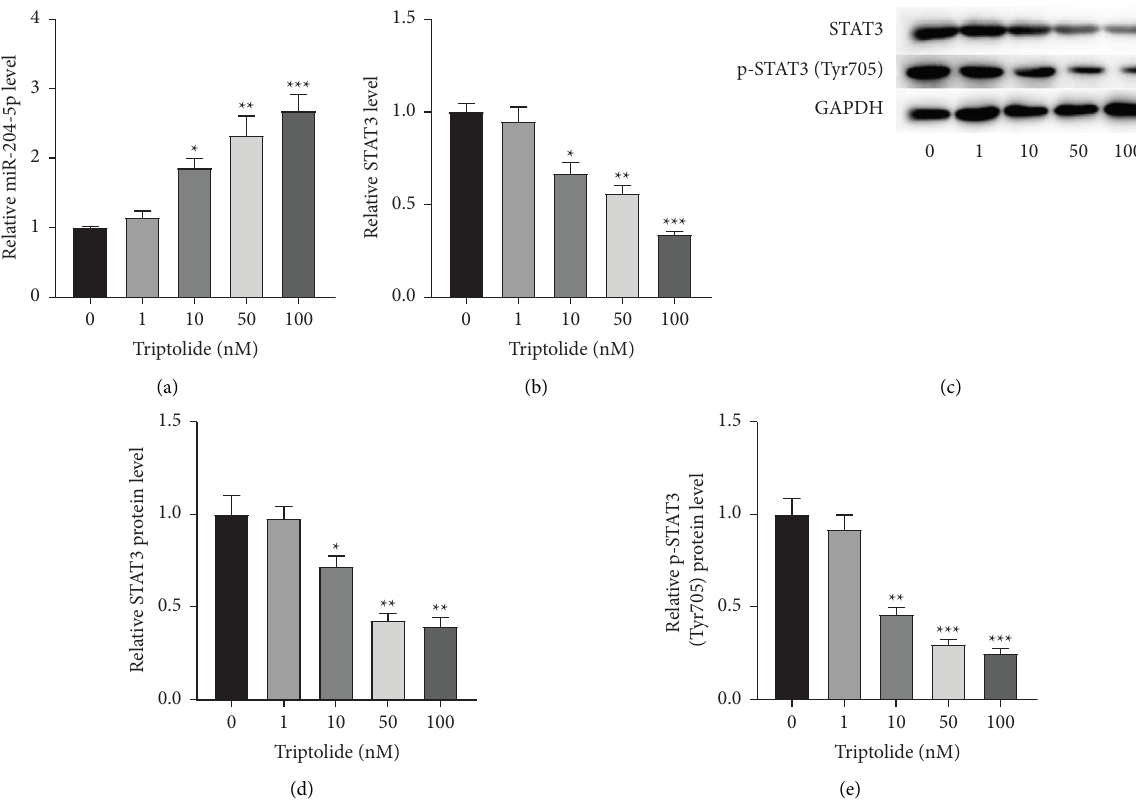
Figure 2: MiR-204-5p and STAT3 expression in triptolide-treated HaCaT cells in vitro . HaCaT cells were treated with 0–100nM triptolide.(a and b) MiR-204-5p and STAT3 expressions in triptolide-treated HaCaTcells detected by RT-qPCR analysis. (c and e) Protein levels of STAT3 and p-STAT3 (Tyr705) tested by Western blot analysis. Each bar presents the mean ± standard deviation obtained from three to four separate experiments. Statistical signifcance was determined using two-way ANOVA followed by the post hoc Bonferroni test. ∗ P < 0 . 05, ∗∗ P < 0 . 01, ∗∗∗ P < 0 . 001 compared to the model